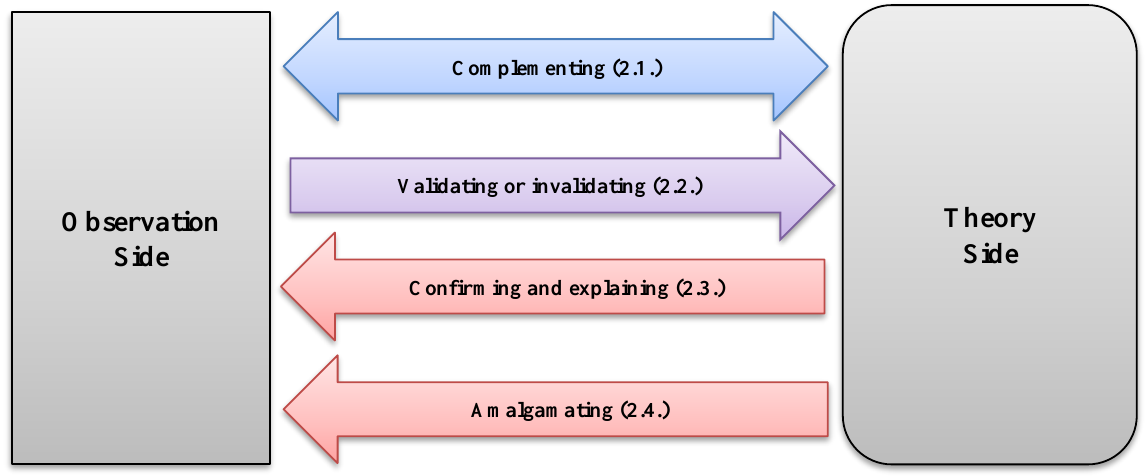
Figure 1. Summary scheme on the observation-theory duo